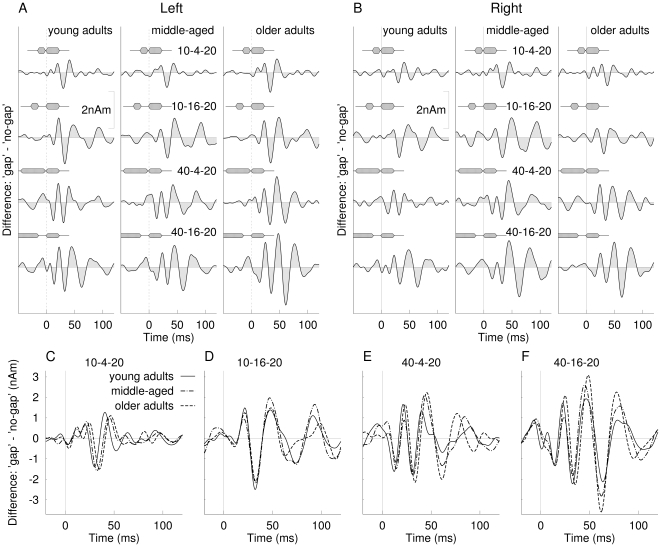
Difference waves between gap and no-gap stimuli for the transient 40-Hz response, the three age groups, and four different stimuli.Time zero of all time scales is adjusted to the onset of the trailing marker. A: Difference waves observed in the left and B: in the right hemisphere. C–F: Overlay of difference waves observed in the three age groups averaged across left and right hemispheres.